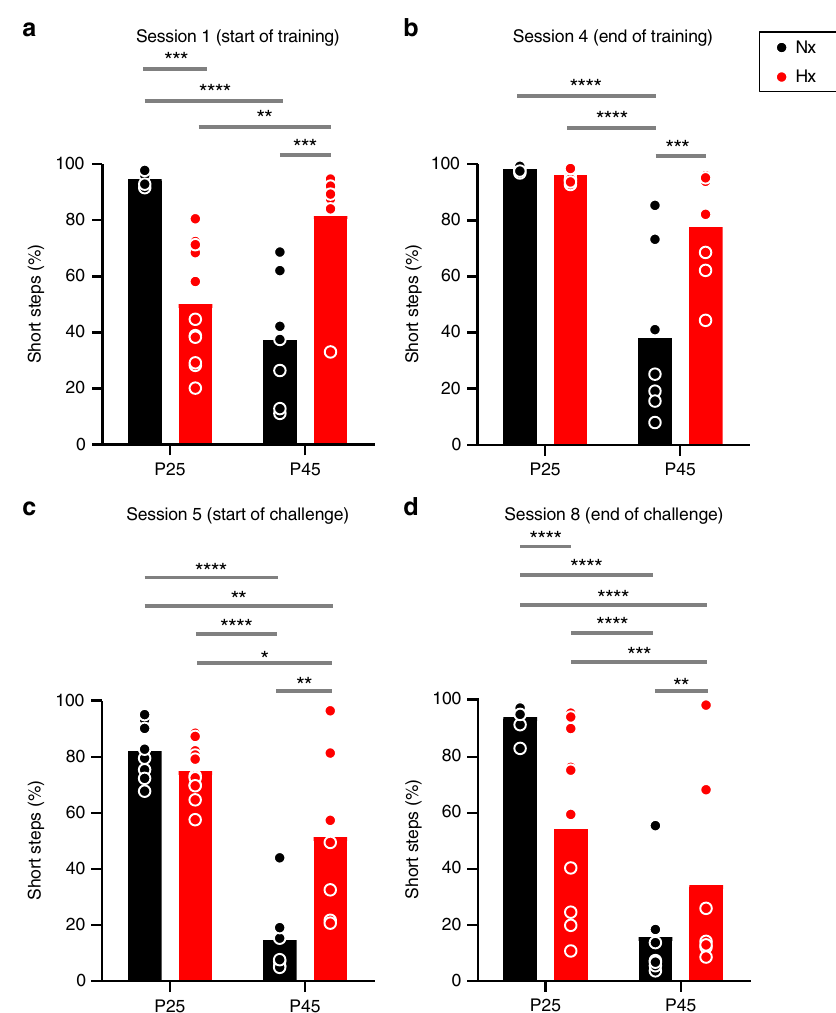
Fig. 5 Locomotor-stepping pattern is altered in Hx mice across age groups. a Short step percentage measurement in session 1 (start of training) in P25 and P45 Nx (black bar graphs, P25 Nx: n = 8 animals, P45 Nx, n = 7 animals), and Hx, respectively, (red bar graphs, P25 Hx: n = 11 animals, P45 Hx, n = 7 animals). Statistics: two-way ANOVA, age × treatment effect F (1,29) = 44.81, P < 0.0001, age effect F (1,29) = 3.775, P = 0.0618, treatment effect F (1,29) = 0.0007305, P = 0.9786. b Short steps in session 4 (end of training). Statistics: age × treatment effect F (1,29) = 12.67, P = 0.0013, age effect F (1,29) = 45.6, P < 0.0001, treatment effect F = 10.17, P = 0.0034. c Short steps in session 5 (start of challenge), statistics: age × treatment effect F (1,29)